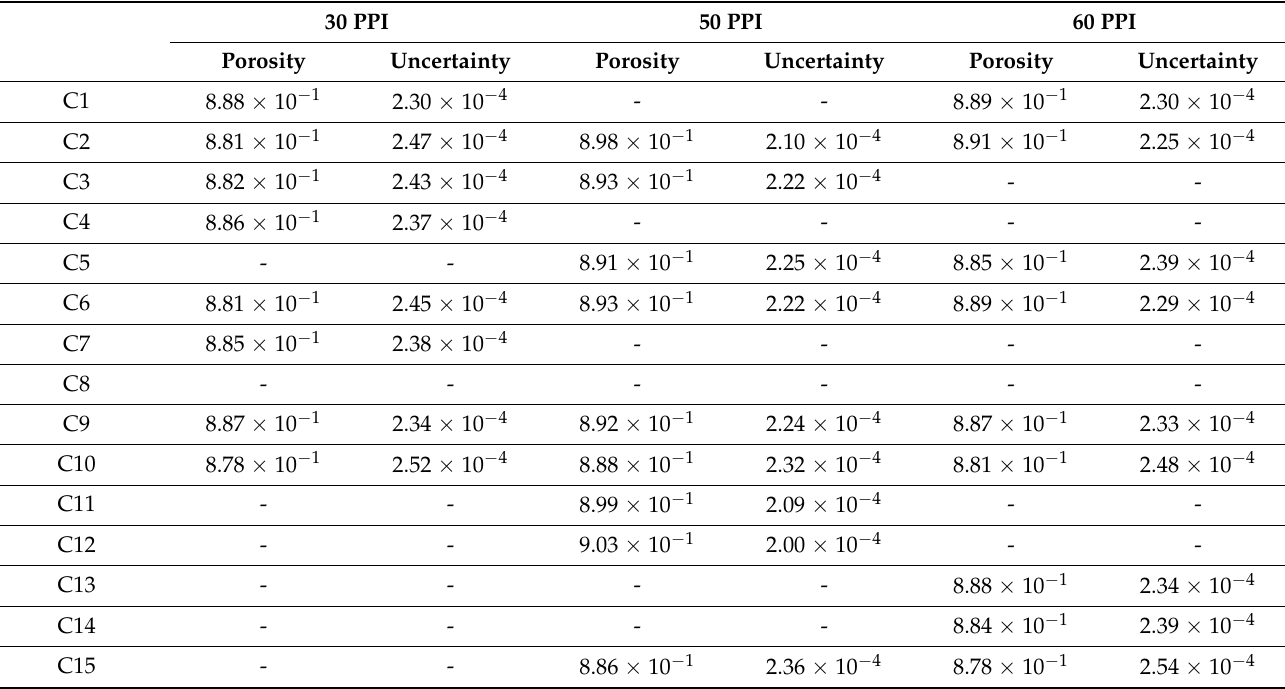
Table A4. The porosity of CFF samples of 30 PPI, 50 PPI and 60 PPI from supplier C. 30 PPI 50 PPI 60 PPI Porosity Uncertainty Porosity Uncertainty Porosity Uncertainty